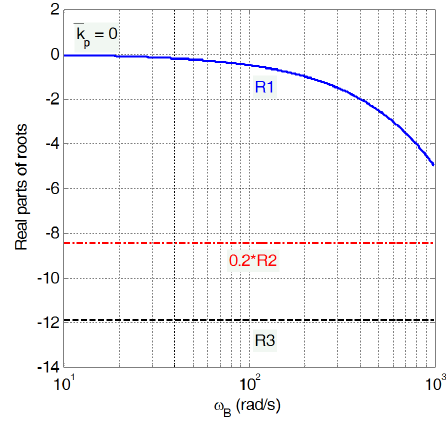
Figure 6. The real parts of characteristic roots when k p = 0.